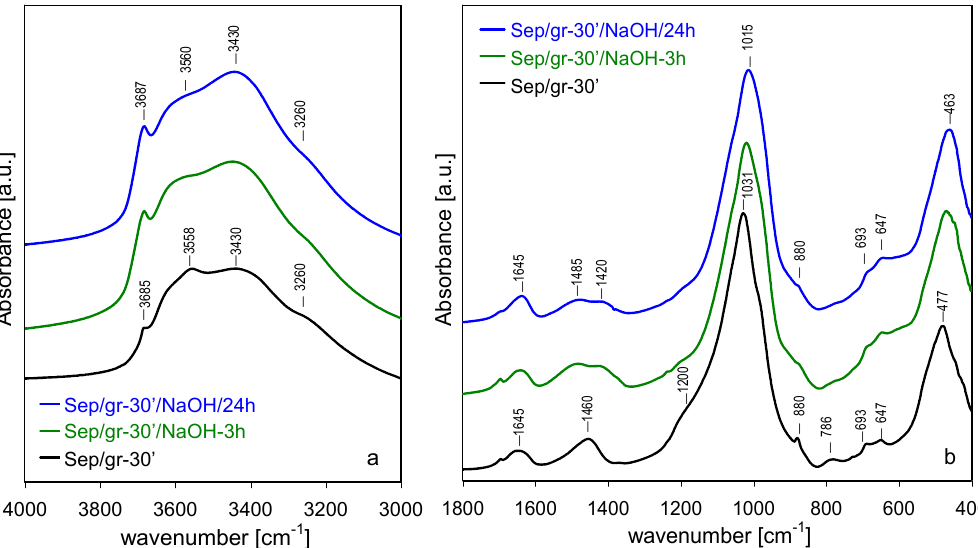
Figure 8. Evolution of FTIR spectra for sepiolite ground for 30 min and treated with NaOH at 90 °C,